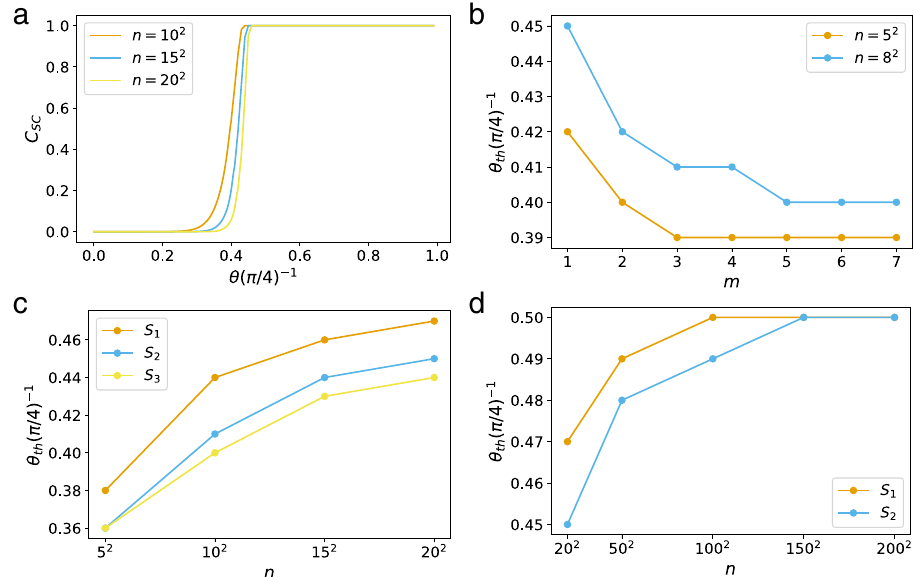
Fig. 6 Fast ConPT calculation on 2D square lattices. a Sponge-crossing concurrence C SC as a function of link weight θ , calculated under the S 1 – S 3 approximations. Only the result of S 3 is plotted. The results of S 1 and S 2 are nearly identical to S 3 . b Numerical ConPT threshold θ th under the S m approximation. As m increases, θ th approaches a constant value. c θ th for different size n . d Same as ( c ) but for larger n . S 3 becomes too computationally intensive to calculate for n > 20 2 . As n increases, θ th also approaches a constant value.